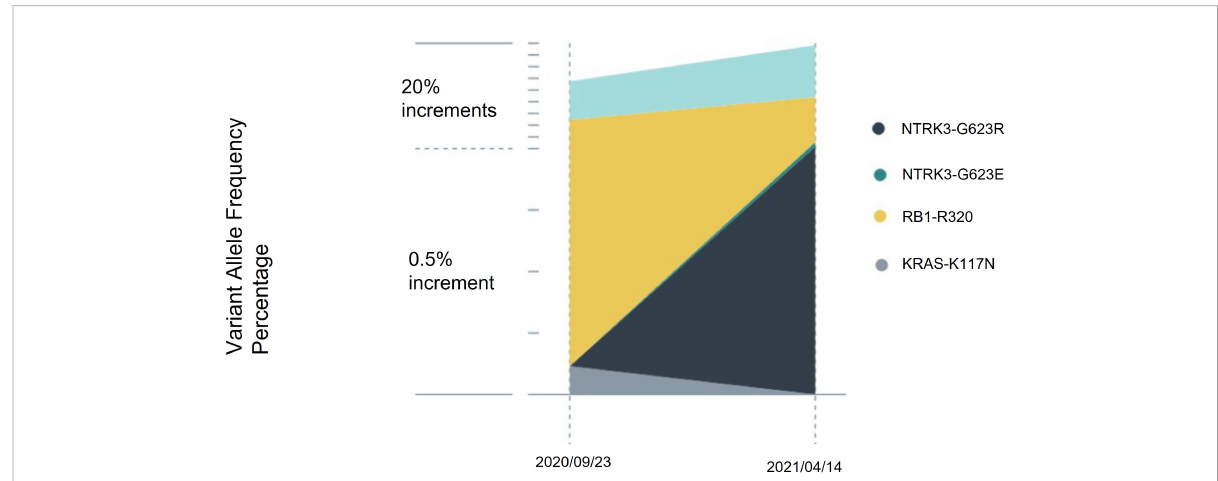
FIGURE 2 Serial cell-free DNA analysis. Circulating tumor DNA was assessed before entrectinib treatment and at treatment failure. After 8 months of entrectinib, the variation allele frequency of ETV6-NTRK3 decreased, and the RAS mutation became undetectable. However, NTRK3-G623R and NTRK3-G623E mutations